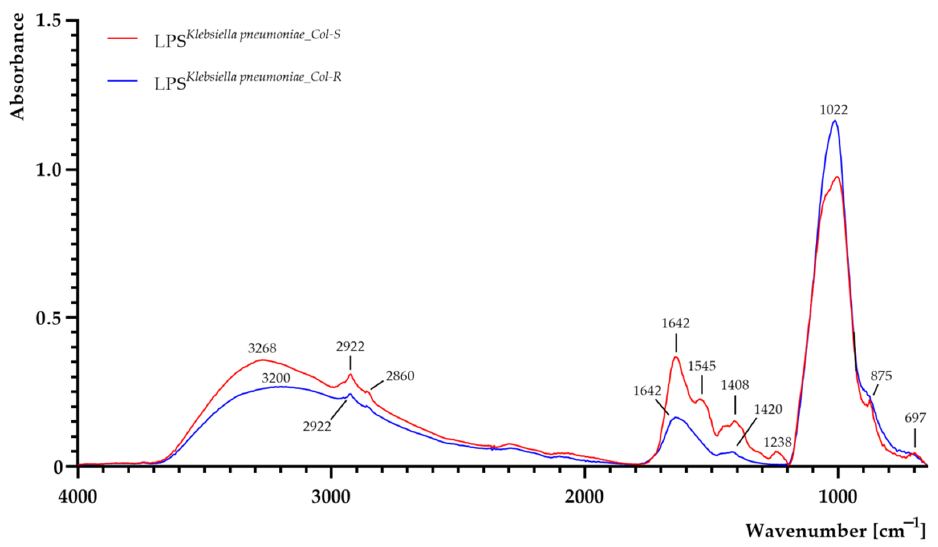
Figure 3. FTIR spectra of lipopolysaccharide (LPS) extracted from colistin-susceptible (LPS K. pneumoniae _ Col-S ) and laboratory-induced high-level colistin-resistant (LPS K. pneumoniae _ Col-R ) Klebsiella pneumoniae strains.